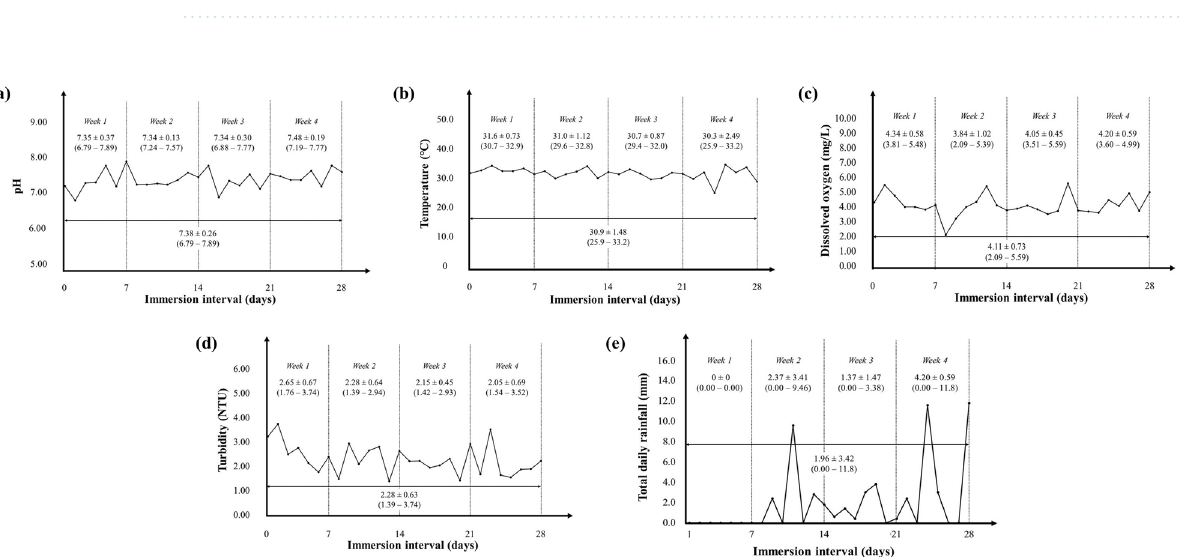
Table 1. The University of Canberra comparative scale used for assessing the performance of two reagent methods A and B at visualising wet latent fingerprints on non-porous substrates. Method A represents NBR, method B is SPR.